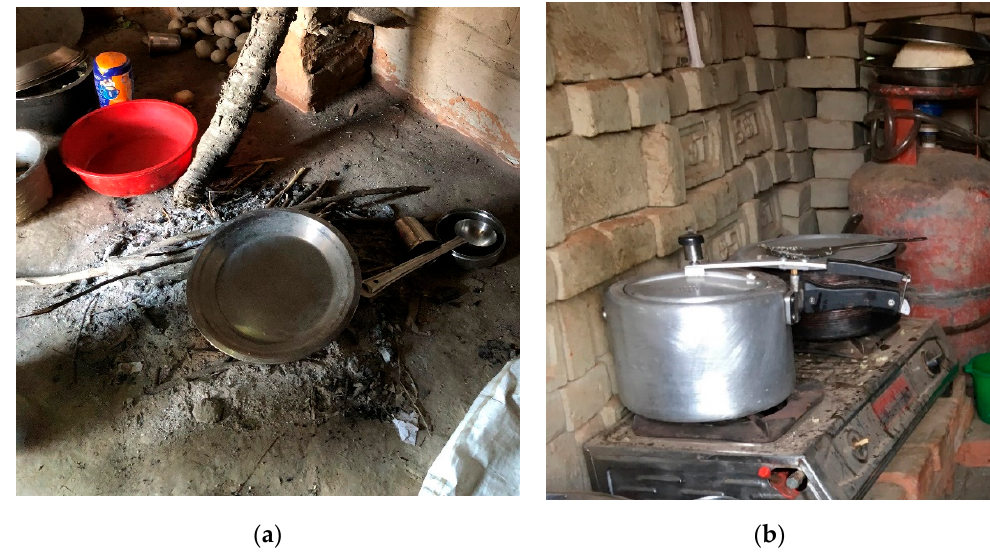
Figure 2. Illustrative examples of the two cooking practices observed in brick workers’ homes in Bhaktapur, Nepal: ( a ) indoor wood fire and ( b ) LPG (liquefied petroleum gas ) cook stove.